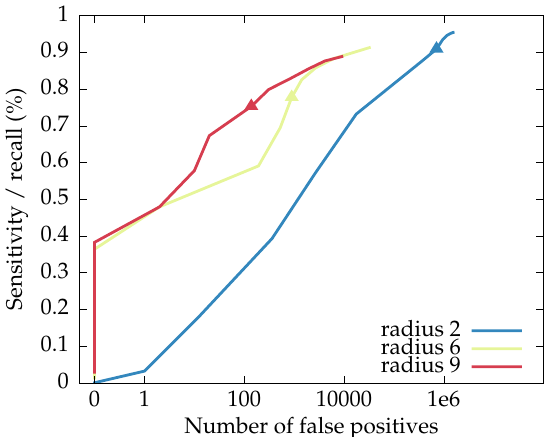
Figure 12. The curves for recall and number of false positives in the function of the threshold used for the response maps of the proposed neural network, with the point for a threshold of 0.5 highlighted. Higher-lying curves are